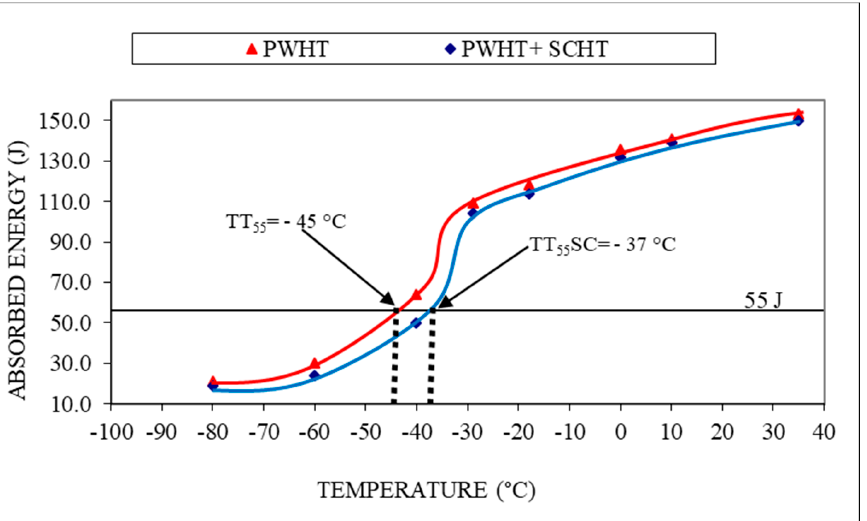
Figure 9. Fracture surface image of Charpy V-notch impact test results at − 80 °C. ( a ) Fractured sur- face and ( b ) SEM image.